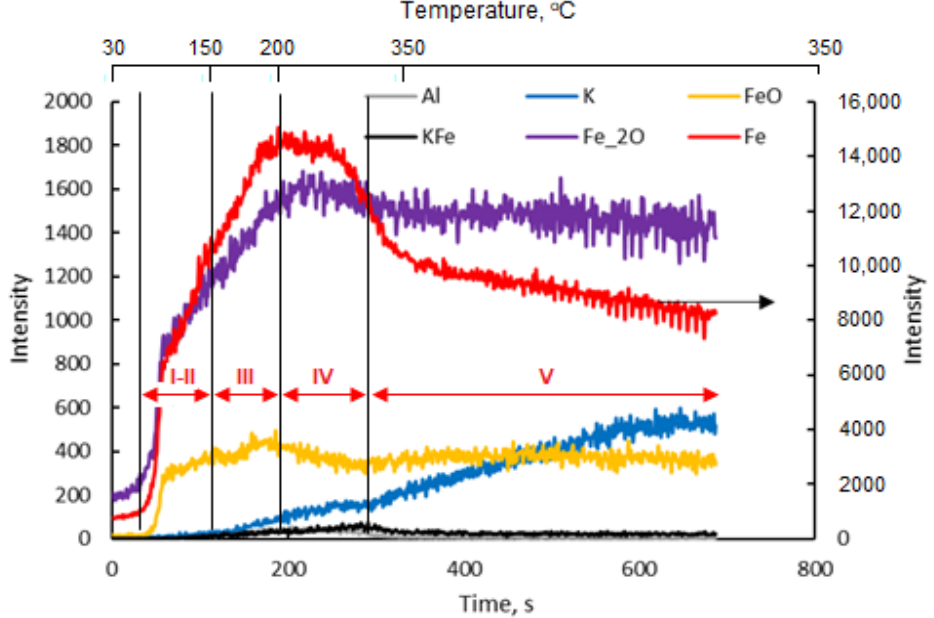
Figure 9. Temperature-programmed TOF-SIMS profile of the Fe-Al sample.